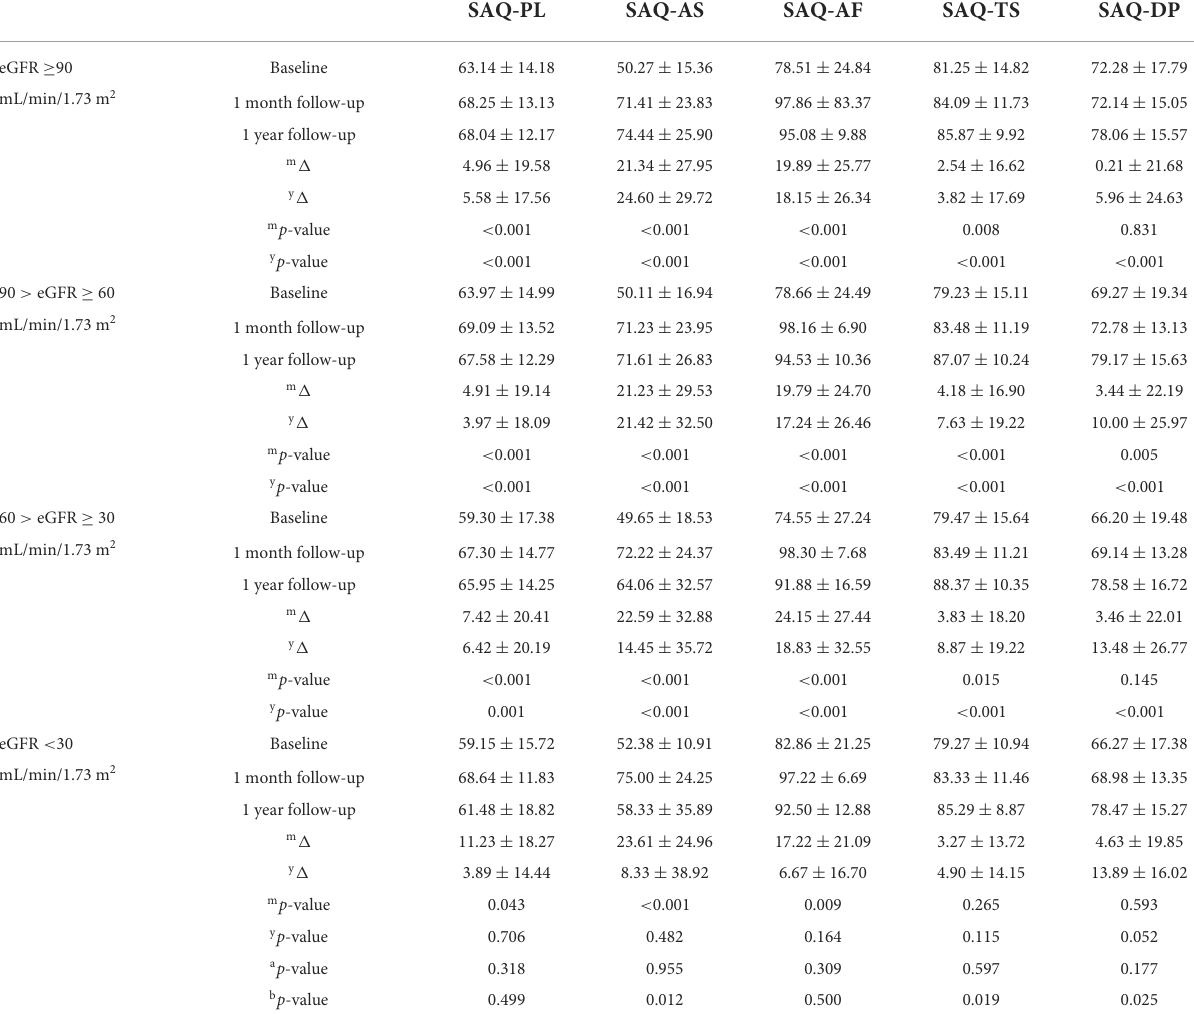
TABLE 5B Comparison of changes in SAQ subscales from baseline to follow-up.